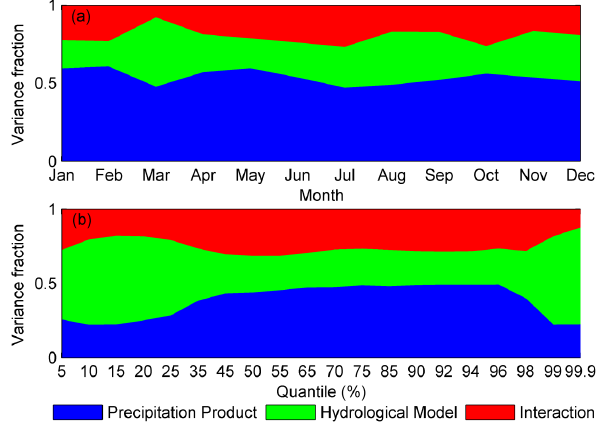
Figure 15. Contributions of uncertainty sources to (a) average monthly discharges and (b) discharge quantiles based on daily-scale simulated